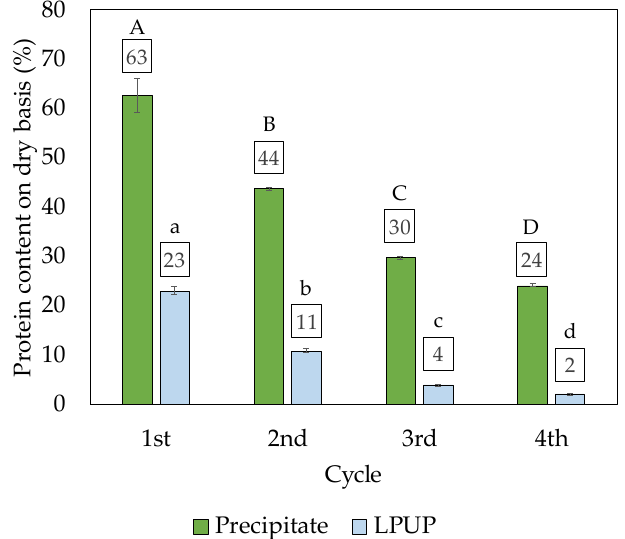
12% and 4% protein were extracted from the starting material in each cycle (Figure 3b). Figure 2. Protein content on dry basis in the precipitate (green) and the LPUP (blue) for the four recirculation cycles. LPUP = light phase with unprecipitated protein. Different uppercase letters indicate significant differences between precipitates and different lowercase letters indicate significant differences between LPUP, p ≤ 0.05.